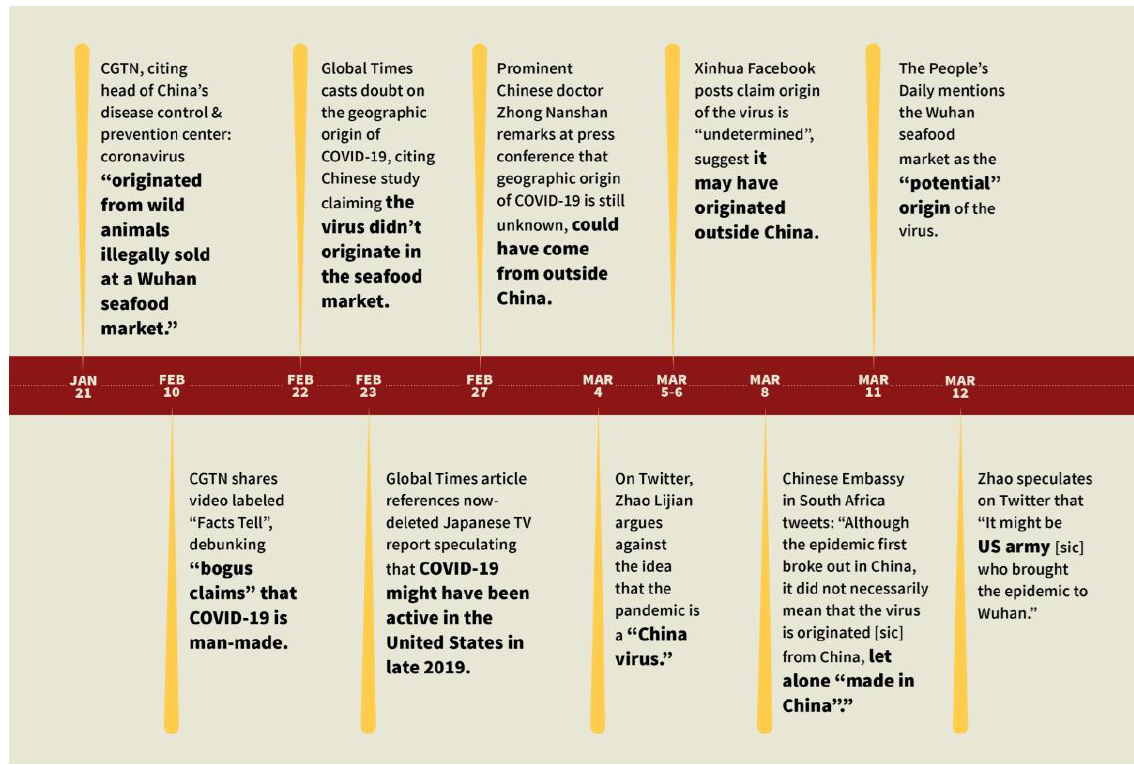
Figure 6 : Timeline of evolving coronavirus origin narrative on several English-language Chinese state media Facebook pages and Twitter